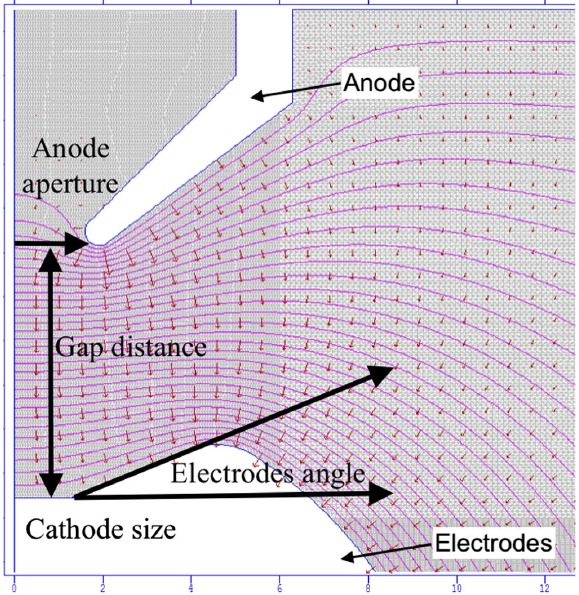
FIG. 2. dc gap geometry and field distribution. The optimized parameters are listed.